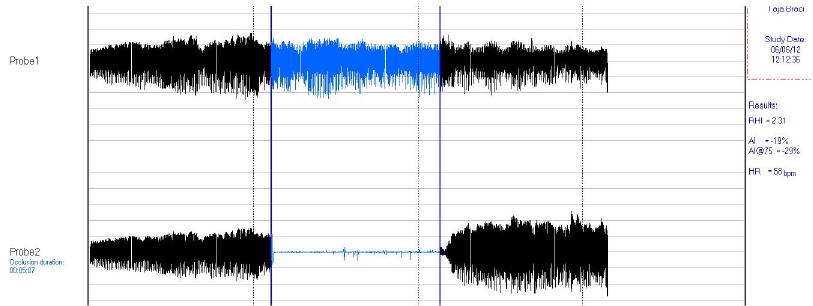
Figure 1. Typical PAT trace recorded on EndoPAT software. Suprasystolic pressure of the blood pressure cuff was confirmed by a flat line (seen in bottom trace) instead of pulsatile flow during occlusion. The EndoPAT index was calculated by the software and represents the ratio of the post occlusion PAT signal to the baseline signal. doi: